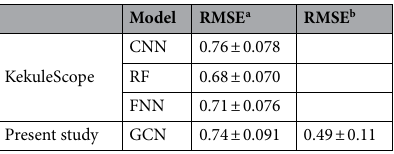
Table 3. Comparison with the KekuleScope. a The KekuleScope dataset. b ChEMBL (release